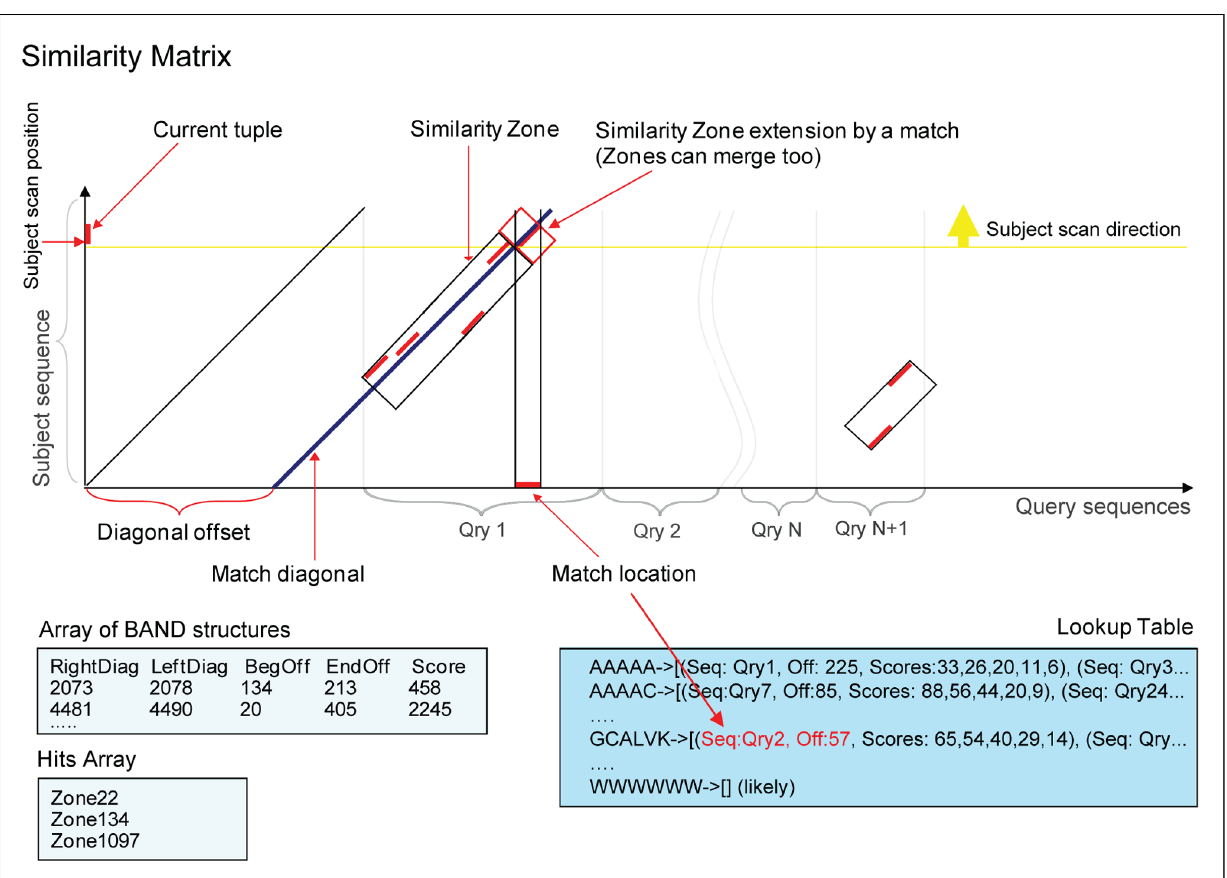
Figure 3. Main elements of the Search Space. ‘Similarity Matrix’ is a rectangular table with columns corresponding to positions in the query sequences and rows corresponding to positions in the ‘current’ subject sequence. Subject sequence database is processed record by record: k-tuples starting from every position are looked up in the Lookup Table, and locations of tuple matches (primary hits) are recorded. Neighboring primary hits form ‘Similarity Zones’, rectangular areas of Similarity Matrix oriented along the diagonals. Each new hit either joins an existing Similarity Zone that appears close by, or forms a new one. If such a hit appears close to more than one existing Zone, the two zones are merged. Similarity Zones are represented in PSimScan as BAND structures. Once a Similarity Zone’s score passes a detection threshold , it gets listed in the ‘Hits Array’.